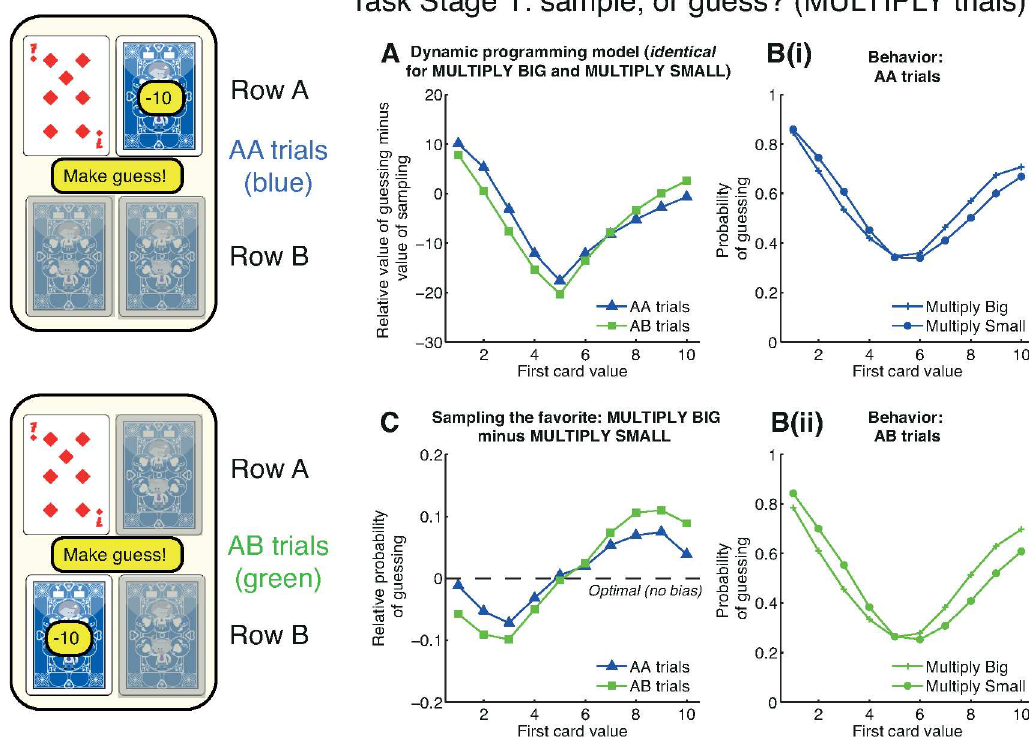
Fig 2. Positive evidence approach bias at Task Stage 1. At Task Stage 1, subjects decide whether to make a guess or pay 10 points to sample. The availablecard to sample may be on the same row (“AA trials”) or the opposite row (“AB trials”) as the first card. (A) Model predictions. The relative expected value (in points) of guessingversus samplingfrom the dynamic programmingmodel in the MULTIPLY conditions. Mid-valued cards make it more valuable to sample, whereas extreme-valued cards make it more valuableto guess. There is a weaker influenceof the location of available information (compare “AA trials” versus “AB trials”). Crucially, optimal behavior is identicalfor both MULTIPLY BIG and MULTIPLY SMALL conditions. (B) Subject behavior. The probability of guessingin both conditionsshows a broad similarity to the predictionsof the dynamic programming model, but behavior in MULTIPLY BIG and MULTIPLY SMALL shows systematic differences. (See S1 Fig for AA and AB trials plotted together, rather than MULTIPLY BIG and MULTIPLY SMALL.) (C) Positive evidenceapproachbias is revealedby subtracting the MUTLIPLY SMALL conditionfrom the MULTIPLY BIG condition. Subjects are more likely to guess early if they have seen evidencethat supports them approaching row A rather than avoiding it. This effect is strengthened in AB trials, in which subjects only have the opportunity to sample further information about row B. See also S2 Fig and S3 Fig for other conditions. Data for reproducing all analysesis freely availablefor downloadfrom